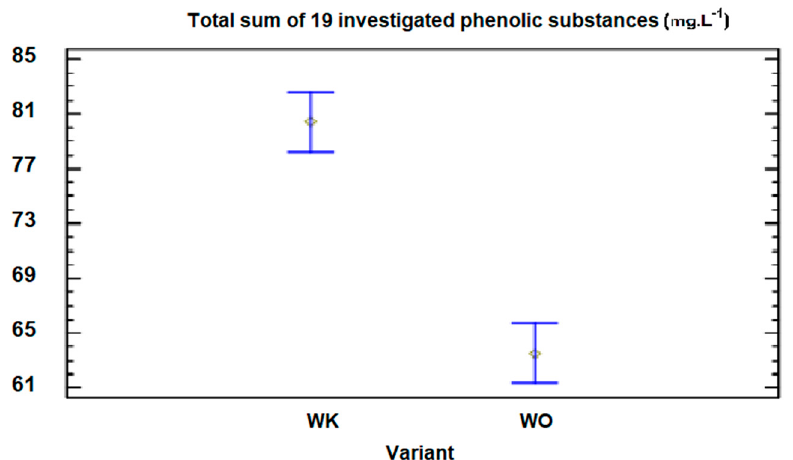
Figure 2. Graphic representation of the 95% confidence intervals of the content of 19 monitored phenolic substances for the tested averages from individual variants in 2015 and 2016 for the Welschriesling variety.